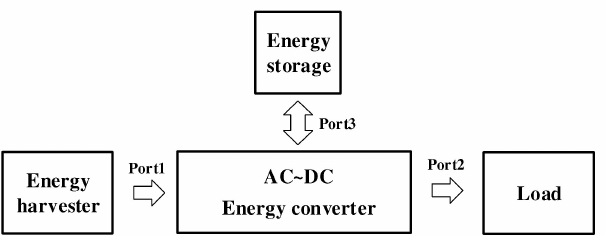
Figure 3. A three-port power converter for EH, with the energy storage module as one port